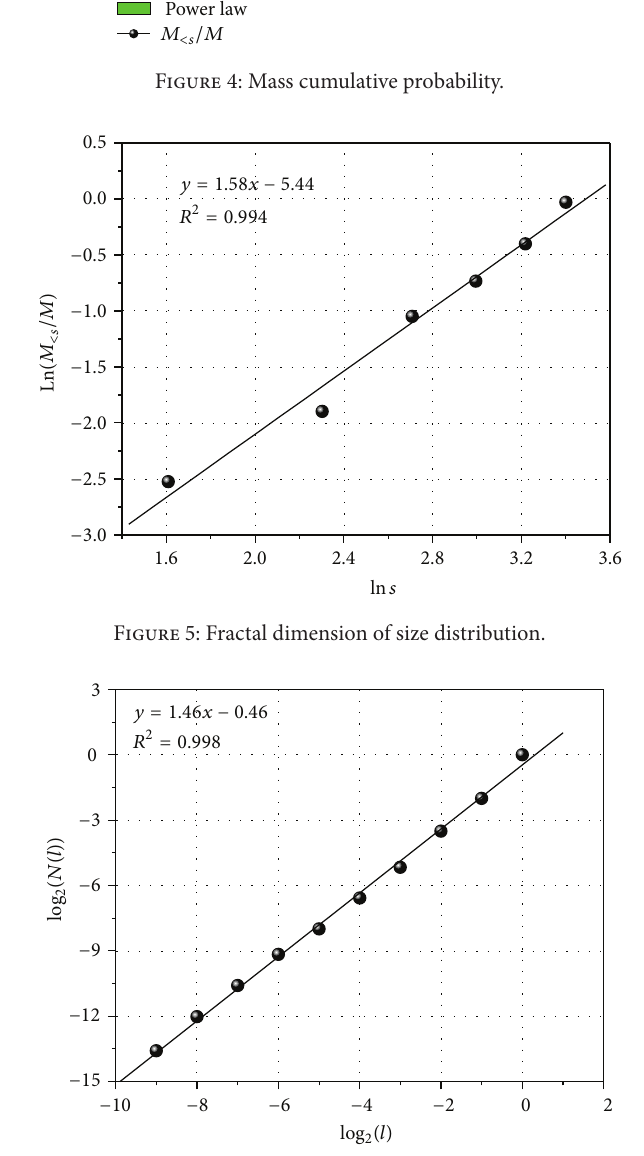
Figure 6: Box-counting dimension of cutting load time series.